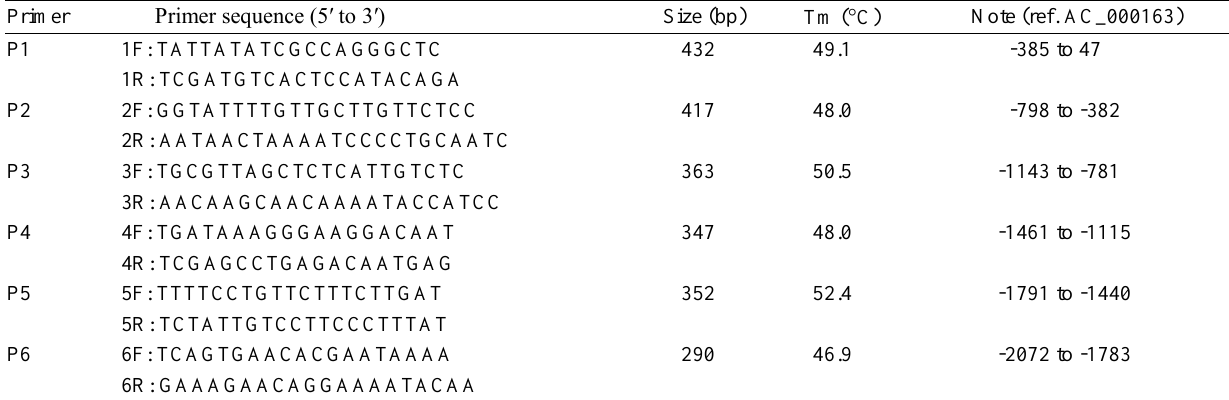
Table 1. Primer information of bovine PPARGC1A gene